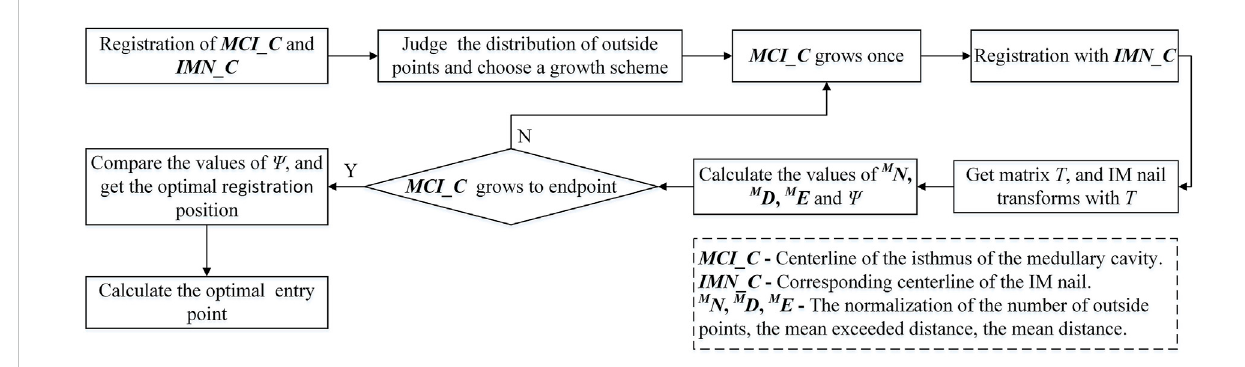
FIGURE 5 Flowchart of the calculation of the optimal registration